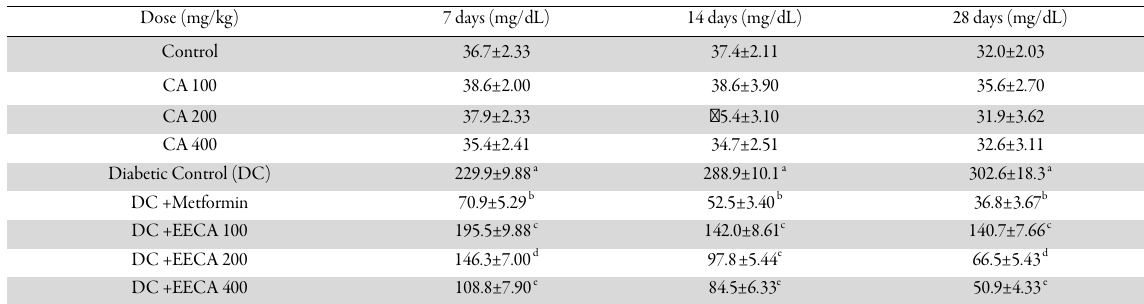
Table 8. Effect of Chrysophyllum albidum on low density lipoprotein cholesterol level of alloxan- induced diabetic